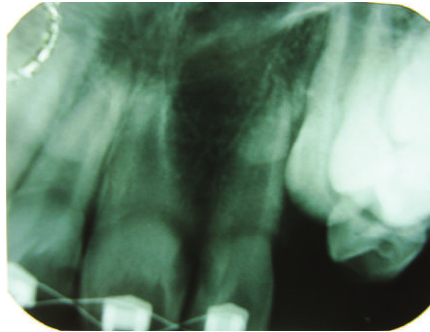
Figure 5: Intraoral periapical radiograph shows root parallelism of 21 and